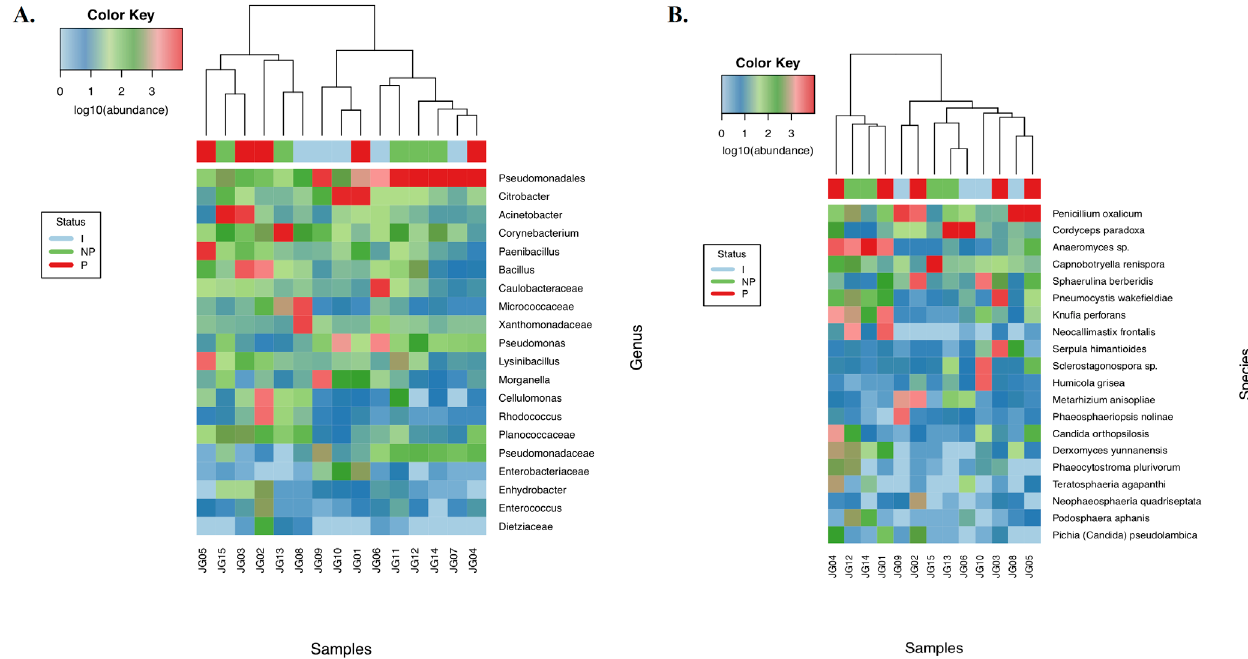
Figure 1. Cluster analysis of bacterial genus ( A ) and fungal species ( B ) compositions in the nares of healthy medical students with a known S. aureus carriage pattern. Heatmap was constructed using normalized log10 abundance of each OTU in each sample type. Data are presented only for the 20 most abundant taxa. Colored bar above heatmap indicates S. aureus carriage status. P: persistent (red), I: intermittent (blue), NP : non-carrier